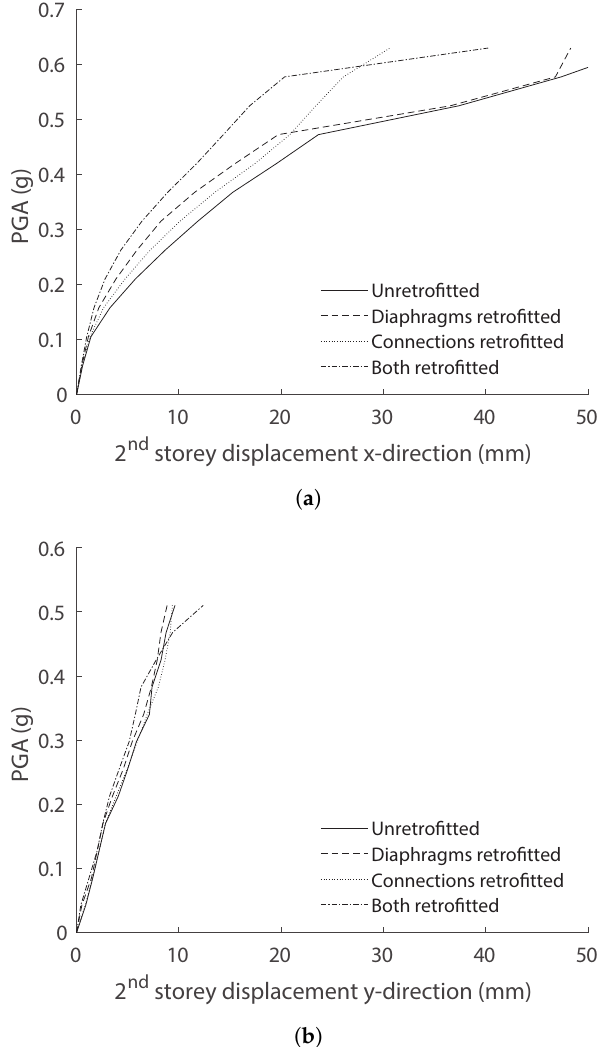
Figure 12. IDA curves for the four configurations in terms of PGA vs. the absolute maximum values of average 2nd storey displacement: ( a ) in the x-direction ( b ) in the y-direction. The IDA curves for the x-direction show that for PGA values below a threshold value (here 0.4725 g), retrofitting the diaphragm reduced the displacements, as the sliding displacements of the diaphragm-wall connections were still small. Therefore, the increased shear stiffness of the retrofitted diaphragm proves effective. However, when the PGA rose above the threshold value, the capacity of the wall-to-diaphragm connection became the weak link, and significant sliding displacements occurred between the floor and wall.